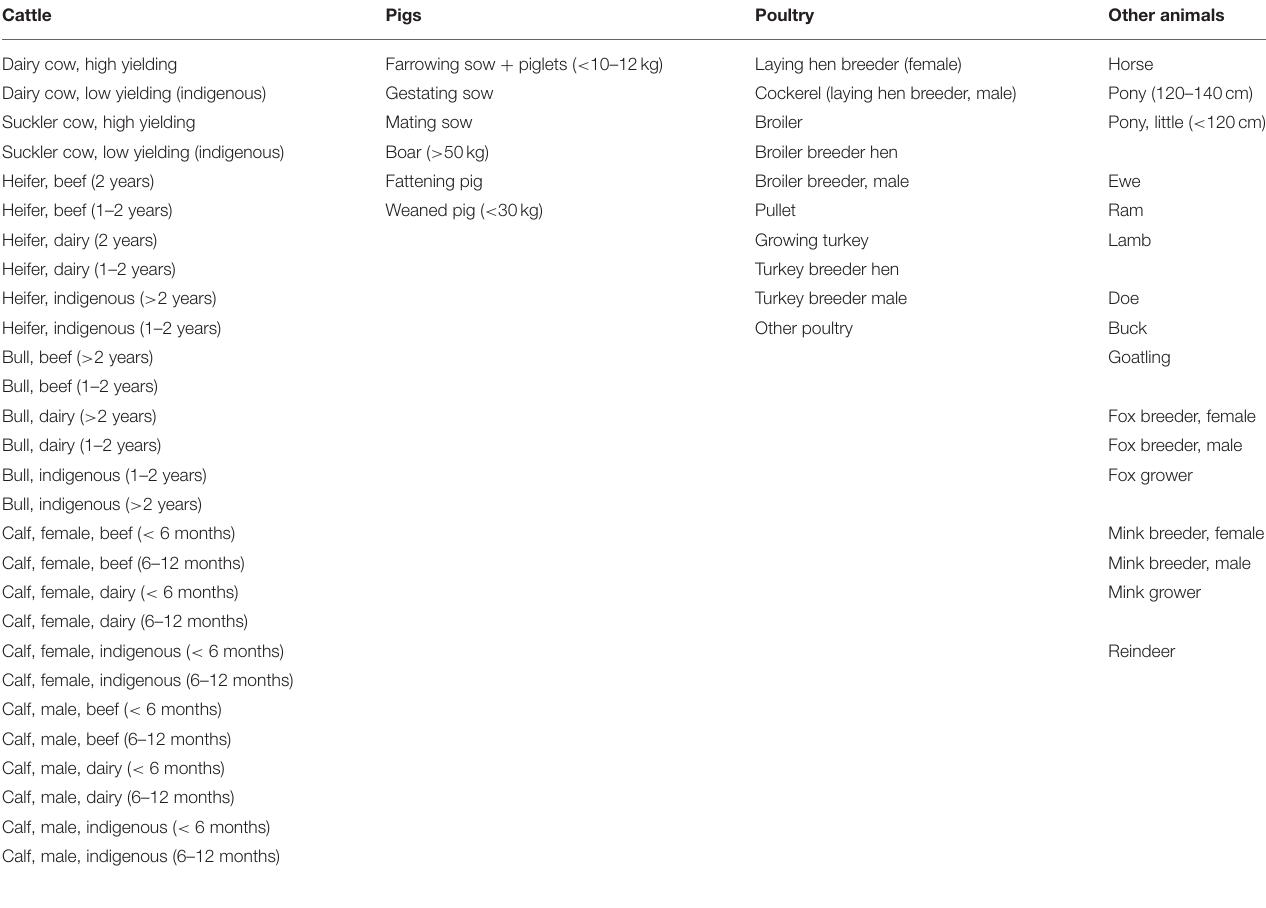
TABLE 2 | Detailed animal categories included into the Finnish Normative Manure System. Cattle Pigs Poultry Other animals Dairy cow, high yielding Farrowing sow + piglets ( < 10–12kg) Laying hen breeder (female) Horse